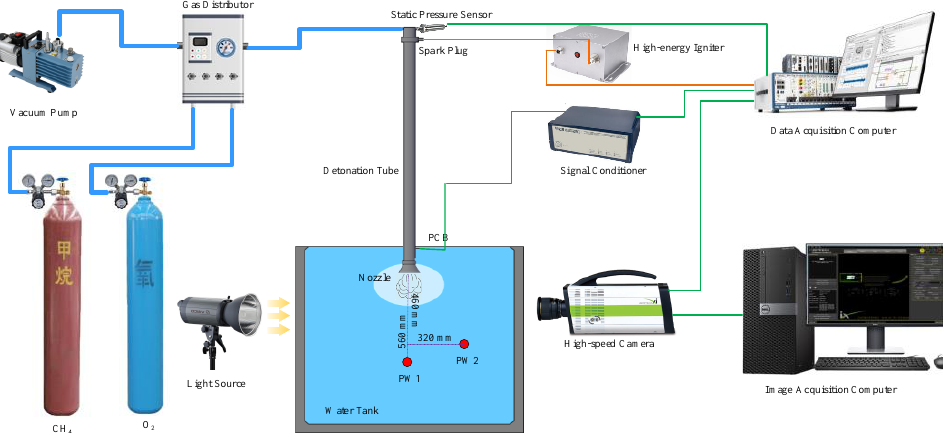
Figure 1. Experimental system of underwater single detonation gas jet.